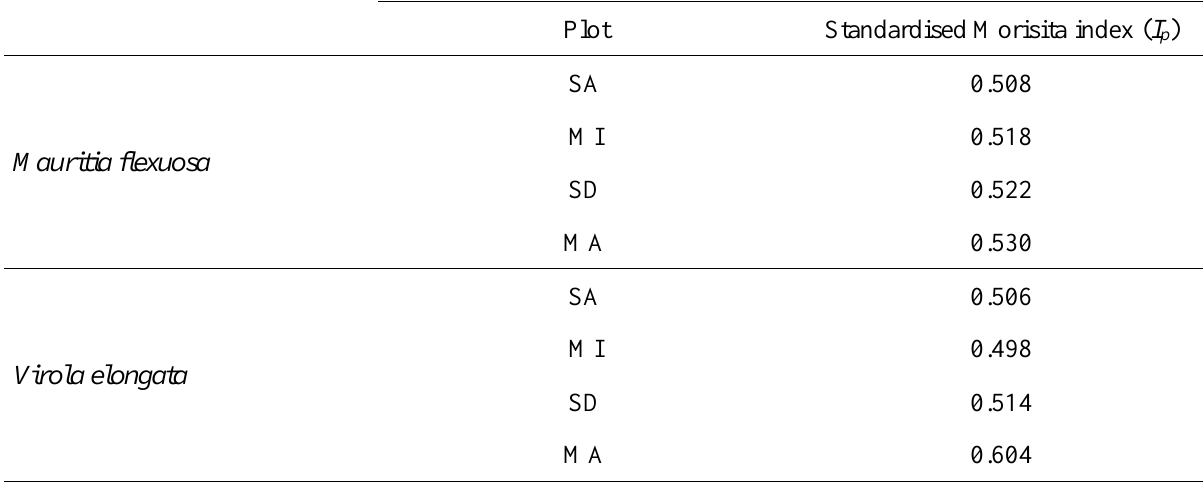
Table 1. Standardised Morisita index for the two most abundant species in the four sampled M. flexuosa palm peat swamp forests in the Alto Mayo Valley (DBH ≥ 10 cm).